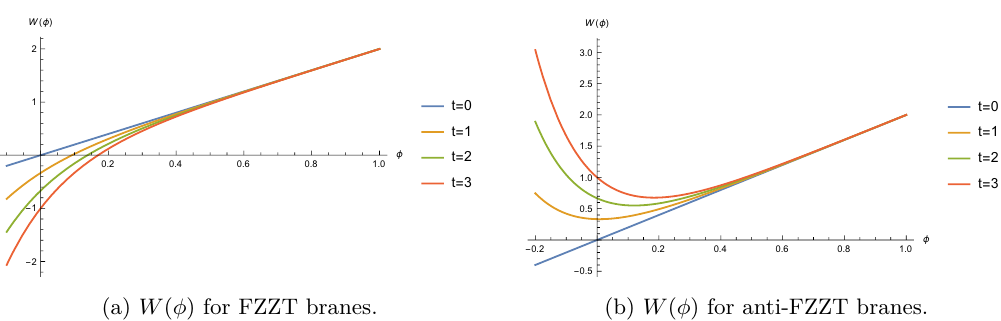
Figure 7 . Plot of W ( φ ) in (6.2) for (a) FZZT branes and (b) anti-FZZT branes. We set ξ = 18 in this plot.